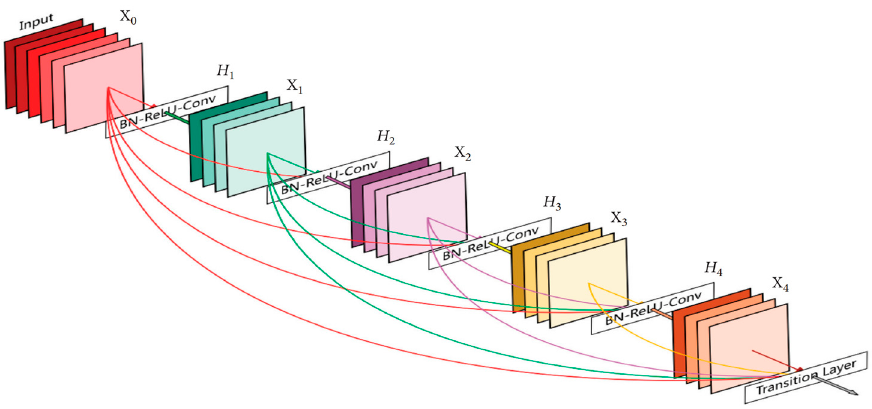
Figure 7. Architecture of DenseNet model. Each layer connects all the subsequent network layers.